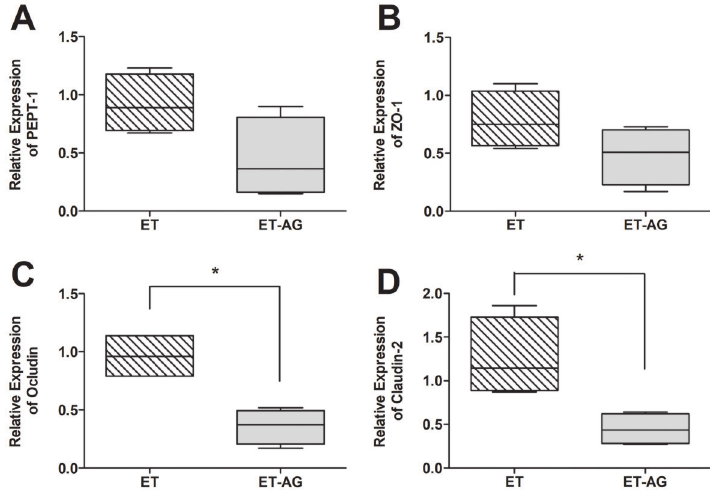
Figure 5. Relative mRNA expression of ( A ) peptide transporter-1 (PEPT-1), ( B ) zonula occludens-1 (ZO-1), ( C ) occludin, and ( D ) claudin-2 between trained animals submitted to an exhaustive test without supplementation (ET group) and trained animals submitted to an exhaustive test supplemented with alanyl-glutamine (ET-AG). The data are reported as median, minimum and maximum, and interquartile range (n=8). *P o 0.05 compared with the ET group (Mann-Whitney